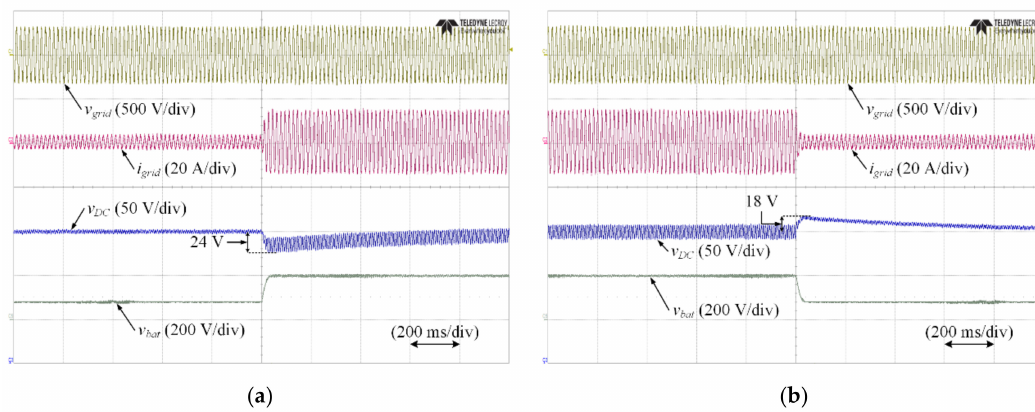
Figure 18. Experimental results of integrated OBC with proposed feed-forward control method in case the power of the battery-side is abruptly changed: ( a ) i bat is changed to 10 A from 4 A; ( b ) i bat is changed to 4 A from 10